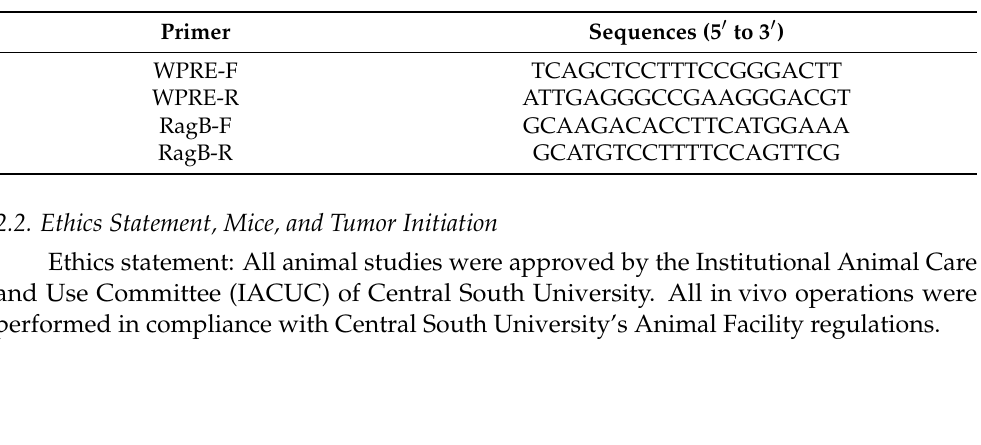
Table 2. The sequence of primers for Lentivirus